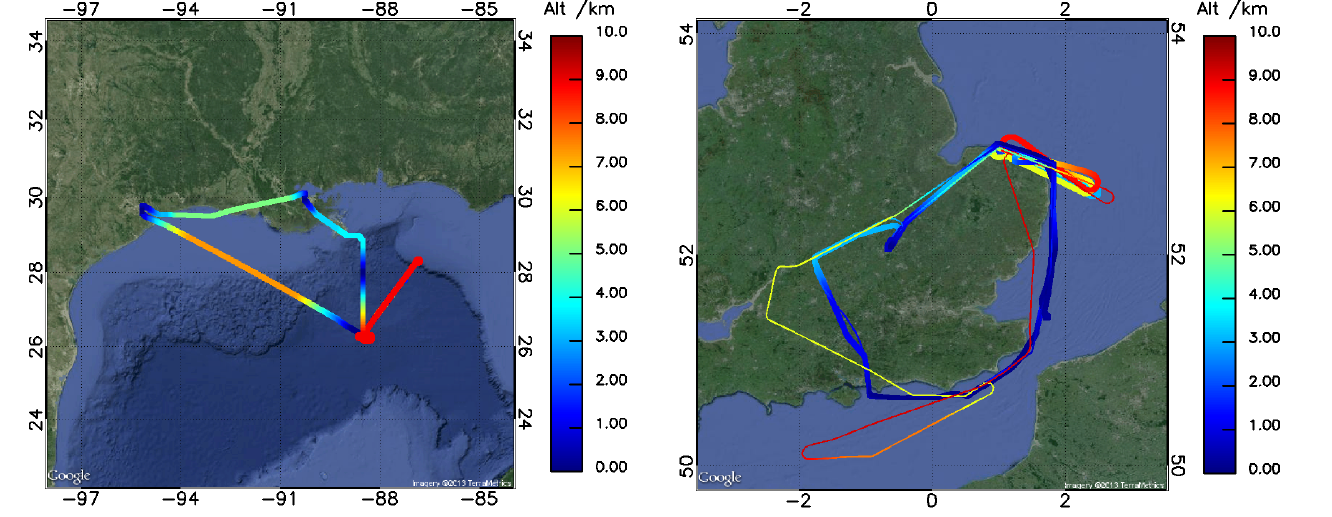
Figure 2. Flight track of FAAM flights B724 (thick track) and B725 (thin track) on 30 July and 9 August 2012, respectively, colour coded for altitude as indicated in the legend. Permission granted by TerraMetrics, Inc to display the imagery shown